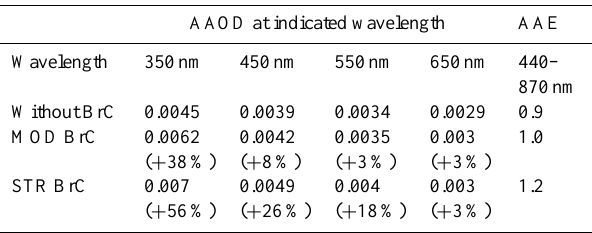
Table 4. Global and annual mean aerosol absorption optical depth (AAOD) and absorption Ångström exponent (AAE) at various wavelengths. The percentage increase in AAOD with the inclusion of BrC is indicated by numbers in